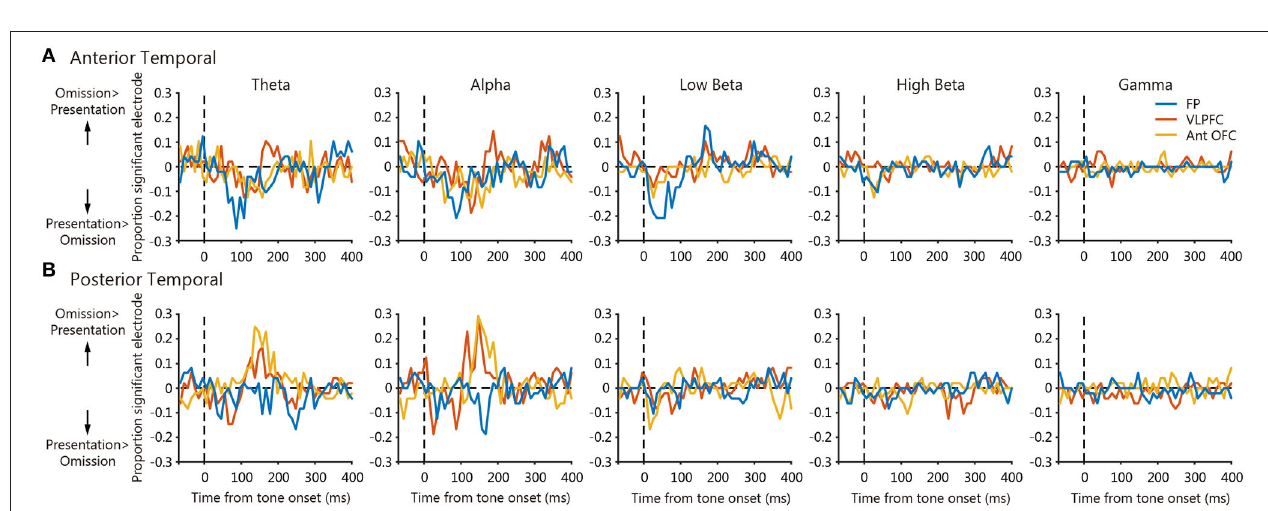
FIGURE 6 | The time courses of the statistical difference map across prefrontal areas. Each panel shows the mean time course of proportion significant electrodes within 3 regions, namely, the frontal pole, the VLPFC, and the anterior OFC. Positive values indicate the proportion of significant electrodes where tone omission PLV was significantly larger than the tone presentation PLV, and negative values vice versa . (A) Panels of the anterior temporal seed. (B) Panels of the posterior temporal seed.